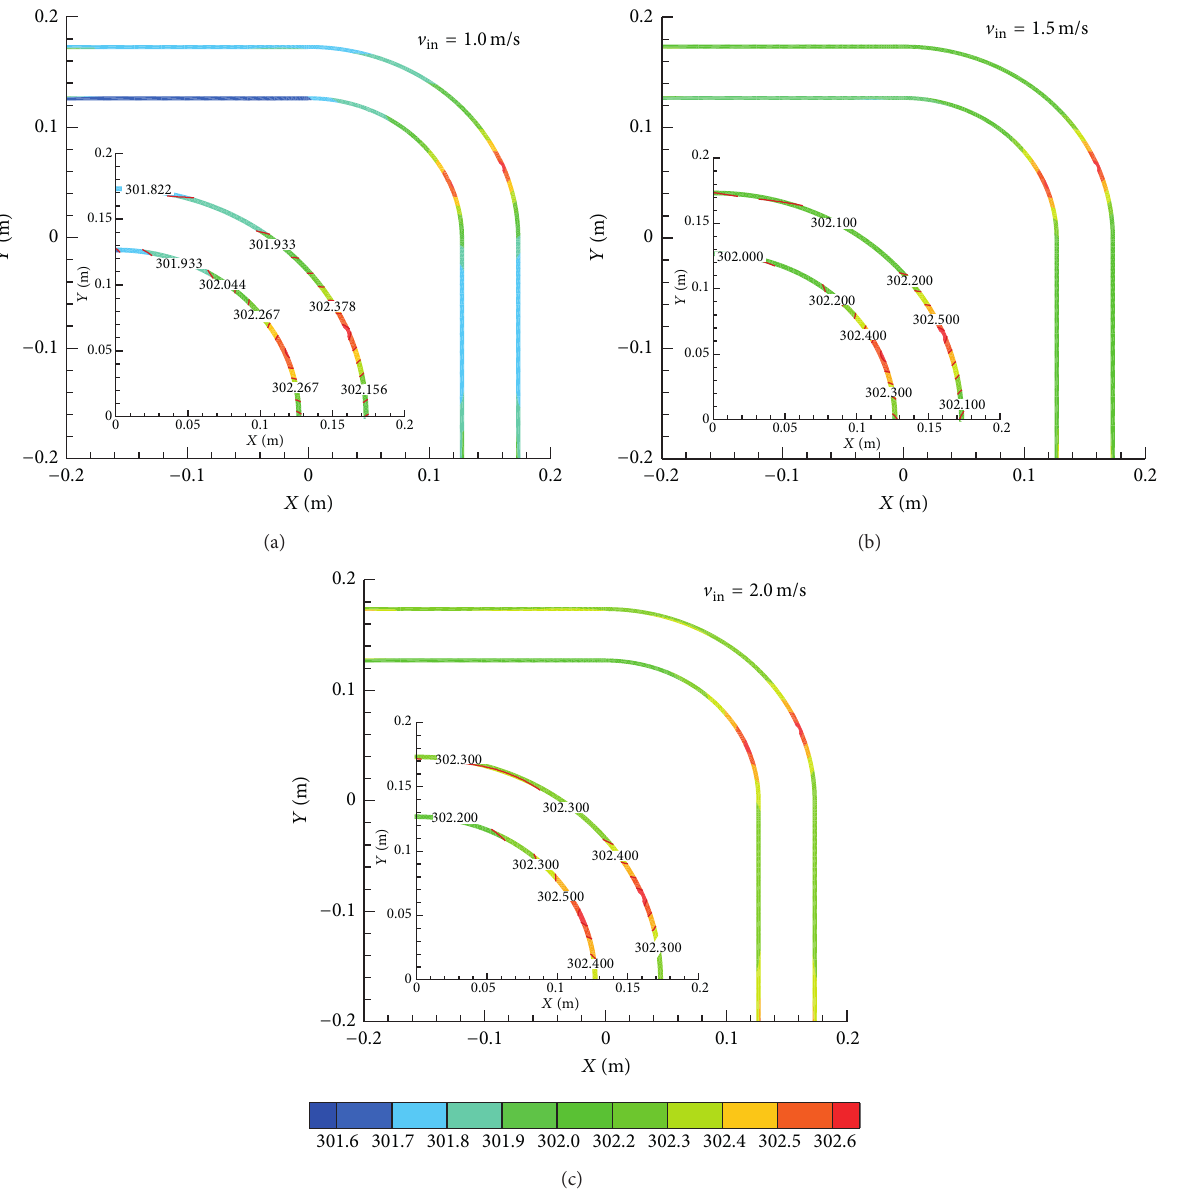
Figure 4: Temperature distribution at the longitudinal cross section of bend pipe at different inlet velocities.